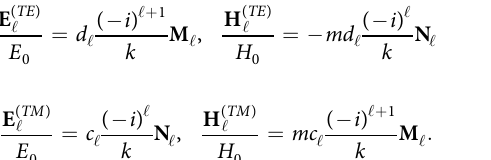
where { F r , F φ , F z } denote the corresponding components of a vector in the cylindrical coordinate frame, whose z -axis is directed along the axis of the cylinder; the prime stands for the derivative with respect to the entire argu- ment of a function; ρ ≡ rk and ω π = = k c f c / 2 / stands for the wavenumber of the incident wave in a vacuum (we remind that ε ≡ m is the complex refractive index of the cylinder). In this case, the complex amplitudes of the electric and magnetic fields within the cylinder, normalized over the corresponding quantities of the plane incident waves ( E 0 , H 0 ), can be presented as infinite series of partial modes  E ,  H , with  varying from minus to plus infinity, and